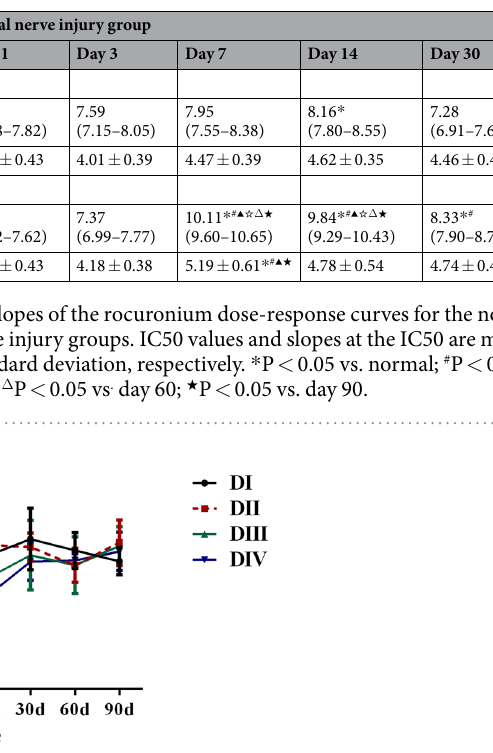
Figure 4. Twitch tension in the DI (grade I), DII (grade II), DIII (grade III), and DIV (grade IV) facial nerve injury groups. Values are means ± standard